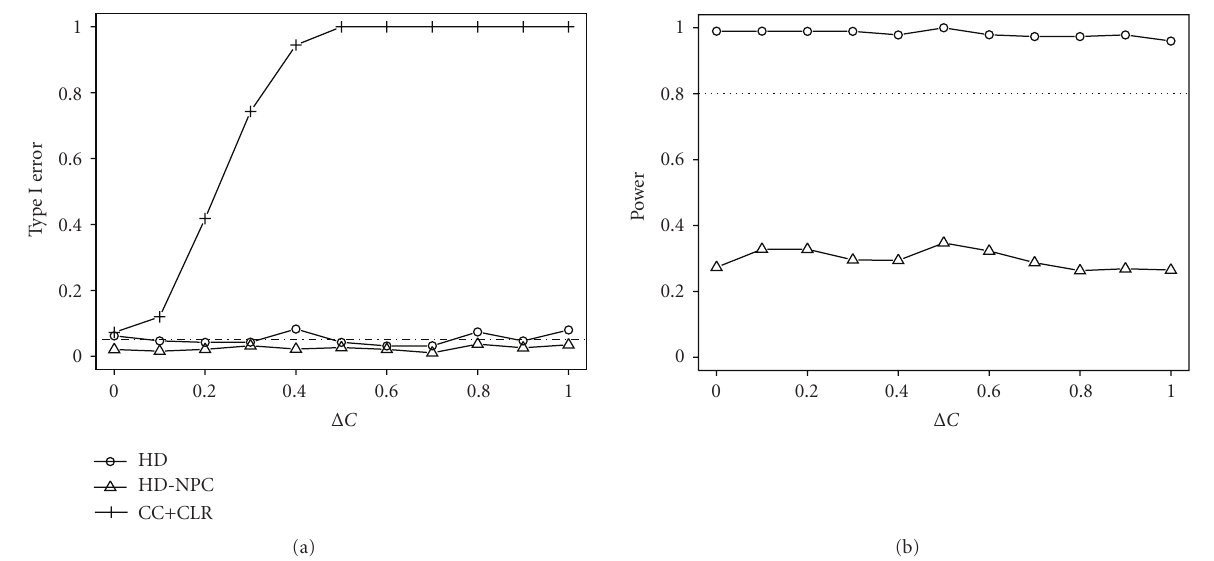
Figure 2: Type I error rates and power for the maternal association test under mating asymmetry. (a) Type I error rates are given for the Mother versus Null test as a function of departure from mating symmetry, as measured by Δ C , under the null model where GC 11 = GC 12 = GC 22 = GM 11 = GM 12 = GM 22 = 1 (Table 2, Model 5). Allele prevalence is set at q = 0 . 3. (b) Power to detect a maternal e ff ect is shown as a function of departure from mating symmetry, as measured by Δ C , for a scenario with multiplicative e ff ects of the mother (Table 2, Model 7). Allele prevalence is set at q = 0 . 3. MA models (9 mating-type parameters) were used for log-linear regression under the assumption of mating asymmetry. Horizontal reference lines indicate type I error rate of α = 0.05 (a) and power = 0.8 (b). HD: hybrid design using parents of controls in a log-linear framework; HD-NPC: log-linear analysis using unrelated controls rather than their parents; CC+CLR: combined case-control and conditional logistic regression analysis.